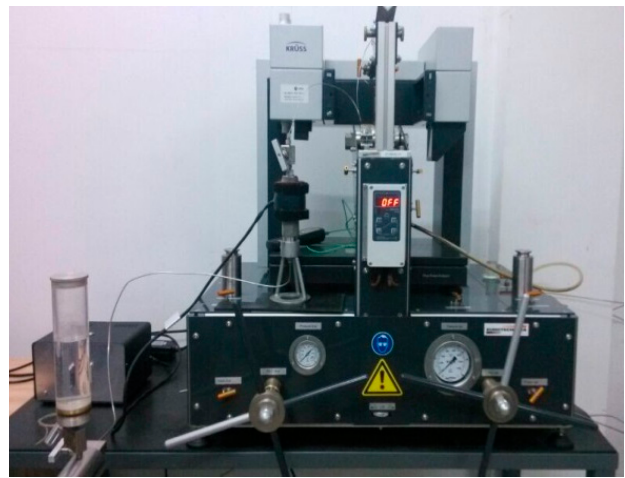
Figure 1. High pressure and high temperature interfacial tensiometer.